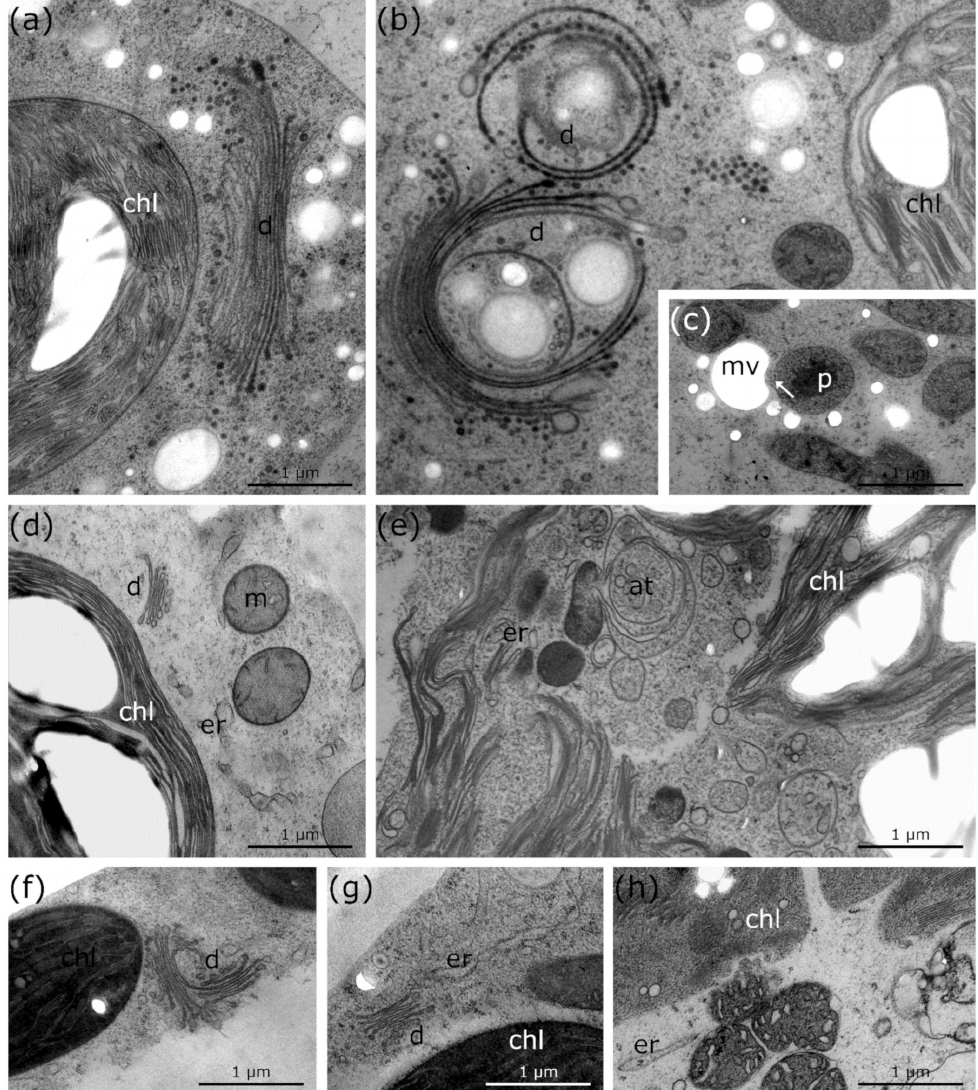
Figure 6. TEM micrographs of Micrasterias denticulata , Lemna sp. and palisade parenchyma cells of Ranunculus glacialis during freezing stress in comparison to controls at + 20 ◦ C. ( a ) Micrasterias control at + 20 ◦ C with regular thylakoid structure of chloroplast and distinct dictyosome shape and number of cisternae. ( b ) Micrasterias during freezing stress at − 2 ◦ C with degrading dictyosomes and